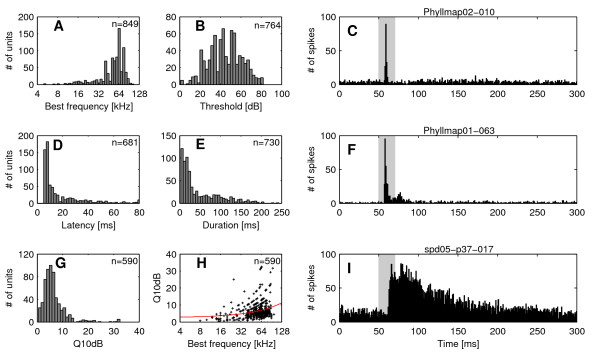
Distribution of response properties of cortical units and examples of PSTHs for different response types. The frequency distribution of neuronal response properties evoked by pure tone stimulation is shown for: A) Best frequency, B) Response threshold, D) First spike latency, E) Response duration and G) Q10dB values. Peri-stimulus time histograms (PSTHs) show examples of cortical units with different response types: C) phasic response, F) phasic response with a sustained component and I) tonic response. The binwidth of the histograms is 1 ms. The grey bar represents the acoustic stimulus (20 ms pure tone). Panel H) shows the Q10dB values as a function of best frequency. The regression line is shown in red.